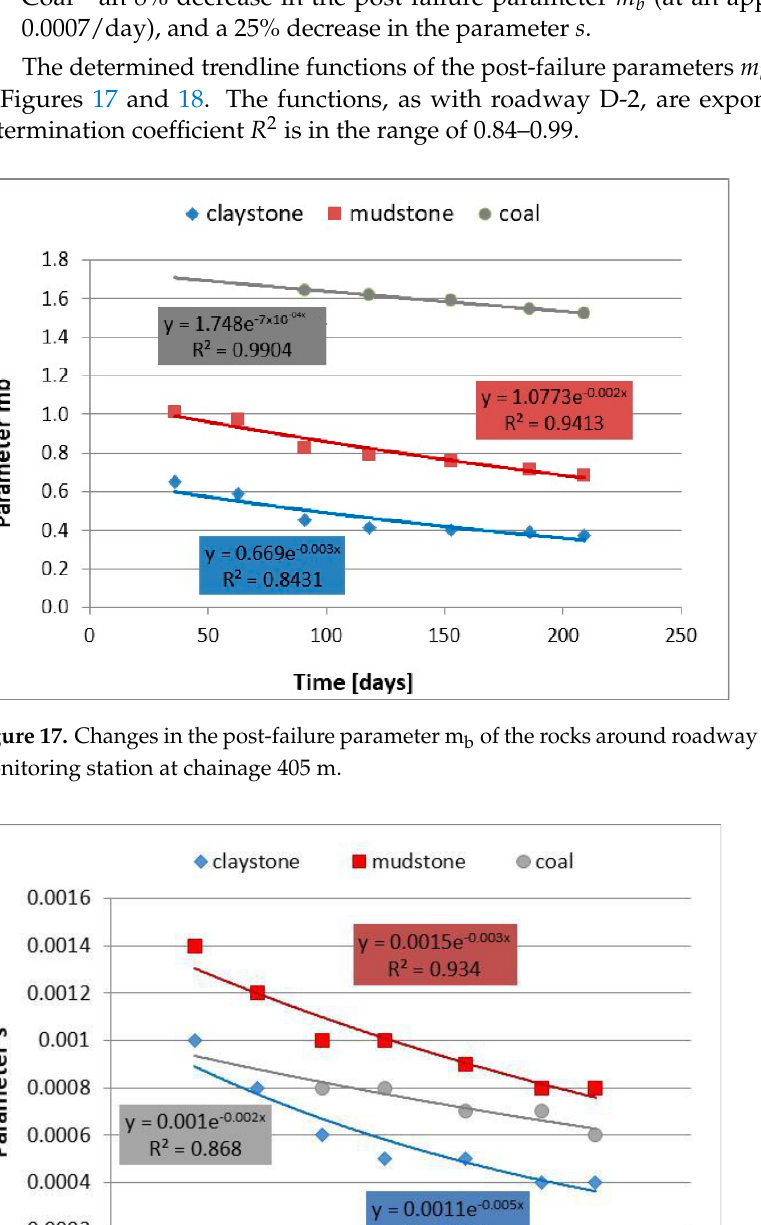
Figure 19. RMR decrease corresponding to m b and s decrease versus time — rocks around roadway F-33. 3.4. Modeling of the Heave of Waterlogged Floor As demonstrated earlier, the heave of the floor with underlying clay rocks is related to the reduction in their strength and deformability parameters. The reduction reflects the gradual process of rock-mass destruction and the slow filtration of water into the floor rocks. Therefore, the following procedure was established for the modeling of the waterlogged floor heave: •